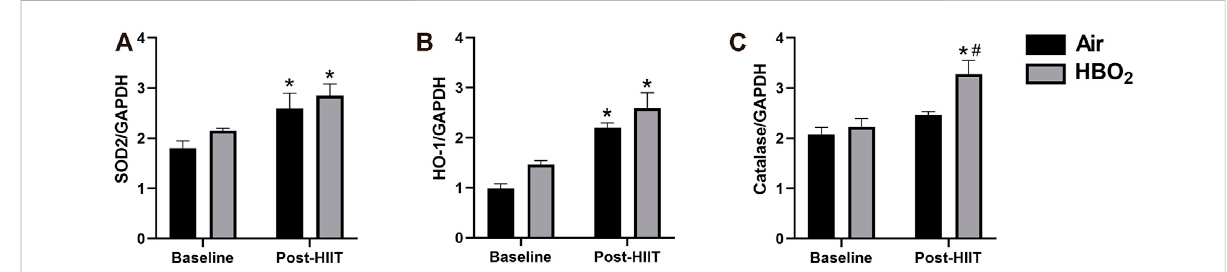
FIGURE 5 Antioxidantresponse.Antioxidantproteinexpressionof (A) SOD2,superoxidedismutase-2; (B) HO-1,hemeoxygenase-1;and (C) catalasewere measured by western blot and referenced to GAPDH expression. Statistical analysis was 2-way ANOVA with repeated measures and Fisher ’ s LSD post-hoc test. * p < 0.05 shows signi fi cant within group comparison (i.e. baseline vs. post-HITT) and # p < 0.05 shows signi fi cant between group comparisons (i.e. air, black bars vs. HBO 2 , grey bars).